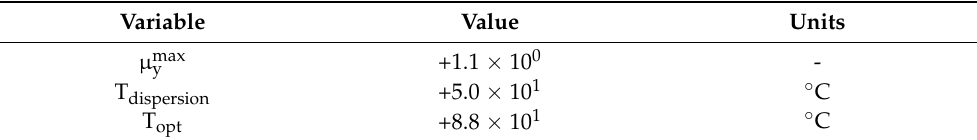
Figure 16. Friction coefficient against temperature. Different averaging methods. Table 4. Values obtained by means of a least squares fitting of Equation